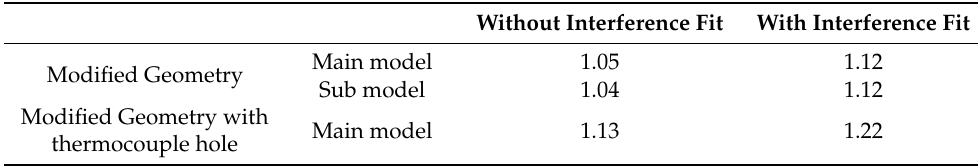
Table 4. Estimated effect of the sensor integration in the tooth root bending